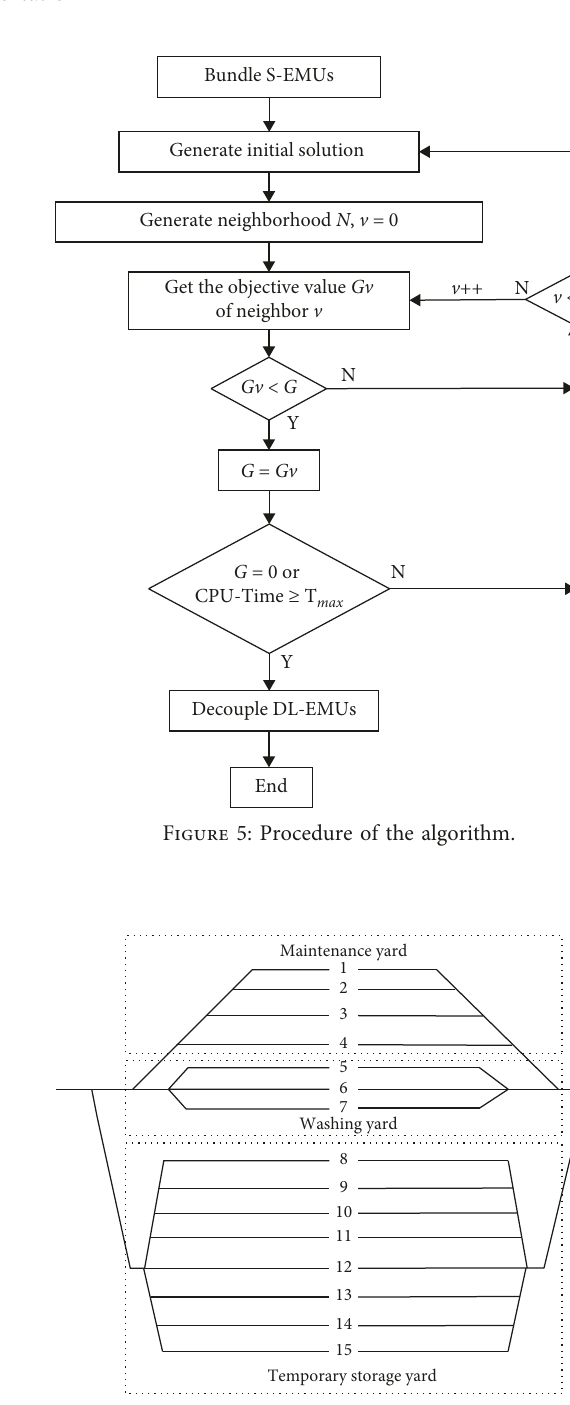
Figure 6: Layout of the EMU depot.